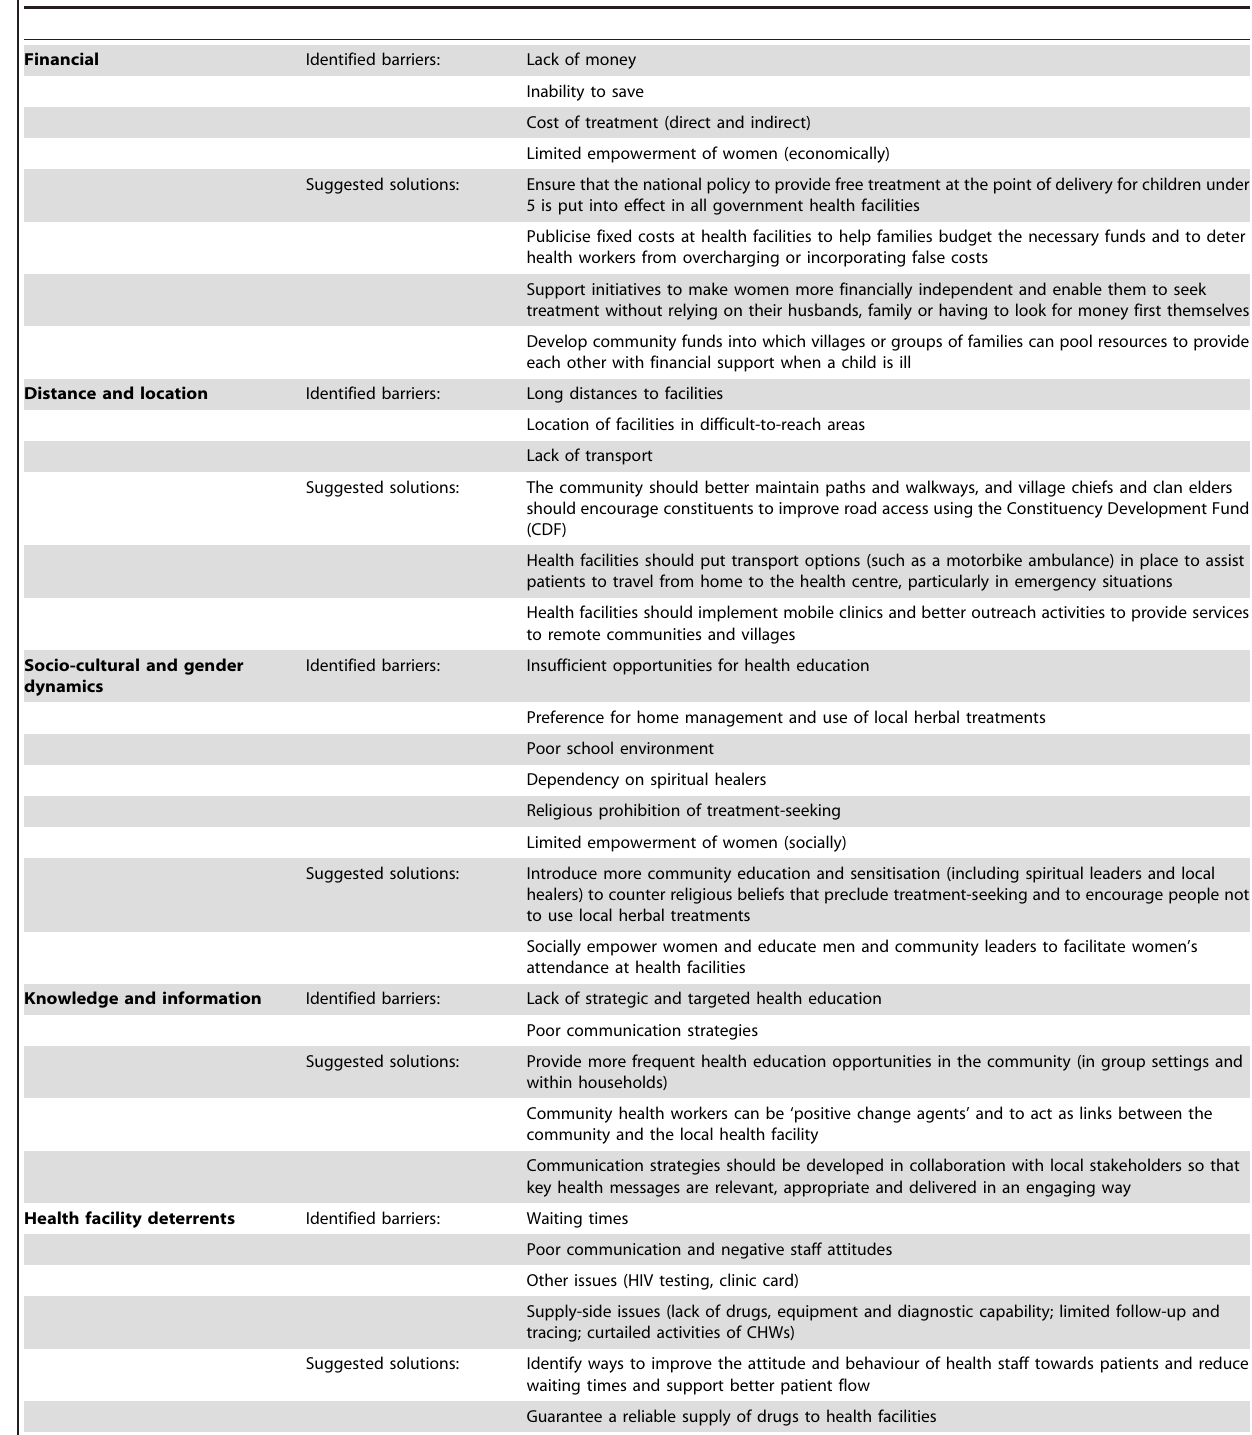
Table 3. Barriers and related solutions identified by caregivers in